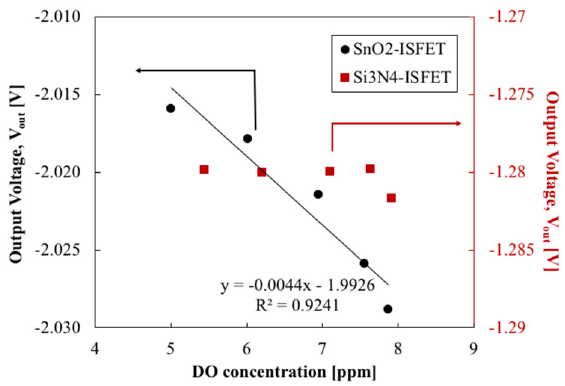
Figure 9. Output voltage of FET in response to DO change.